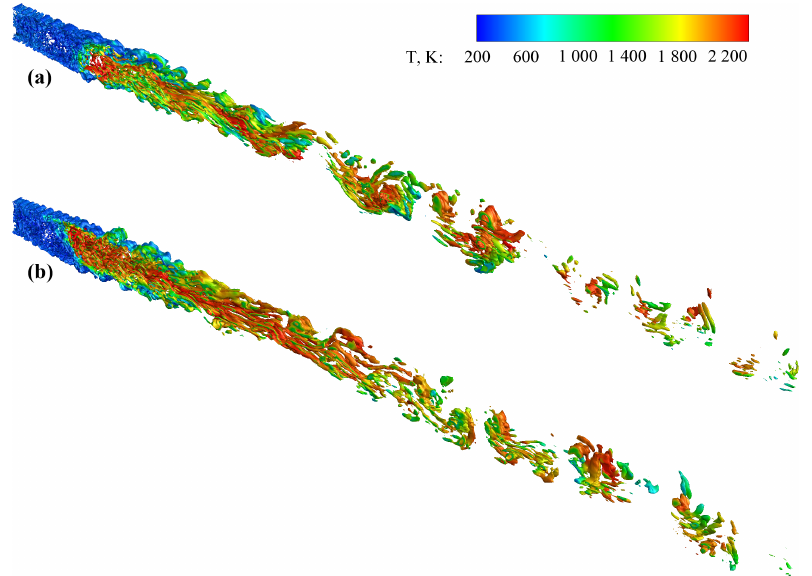
Figure 18. Isosurfaces of swirl strength: ( a ) M1, original scheme; ( b ) M2, modified scheme (colored according to